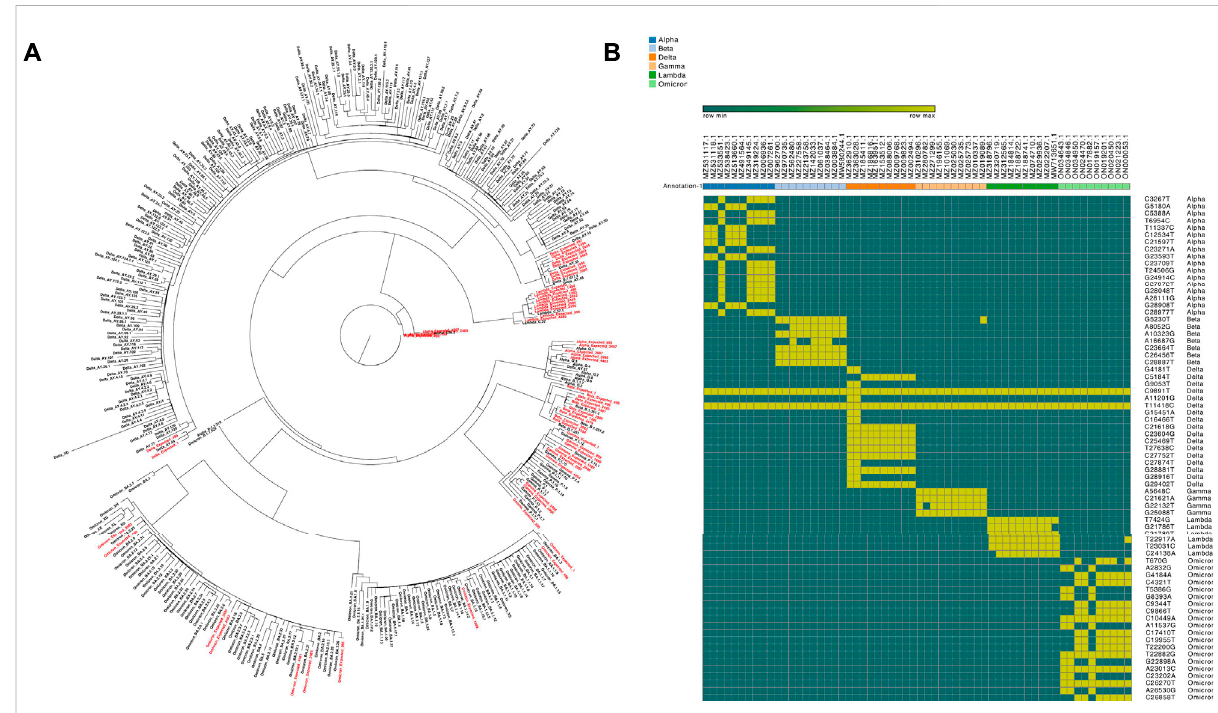
FIGURE 2 Analyticalresultsofsimulatedsequencedatafor60lineages. (A) Theresultofphylogenetictreeanalysis(theredtextrepresentssimulateddata). (B) The heatmap analysis of hotspot